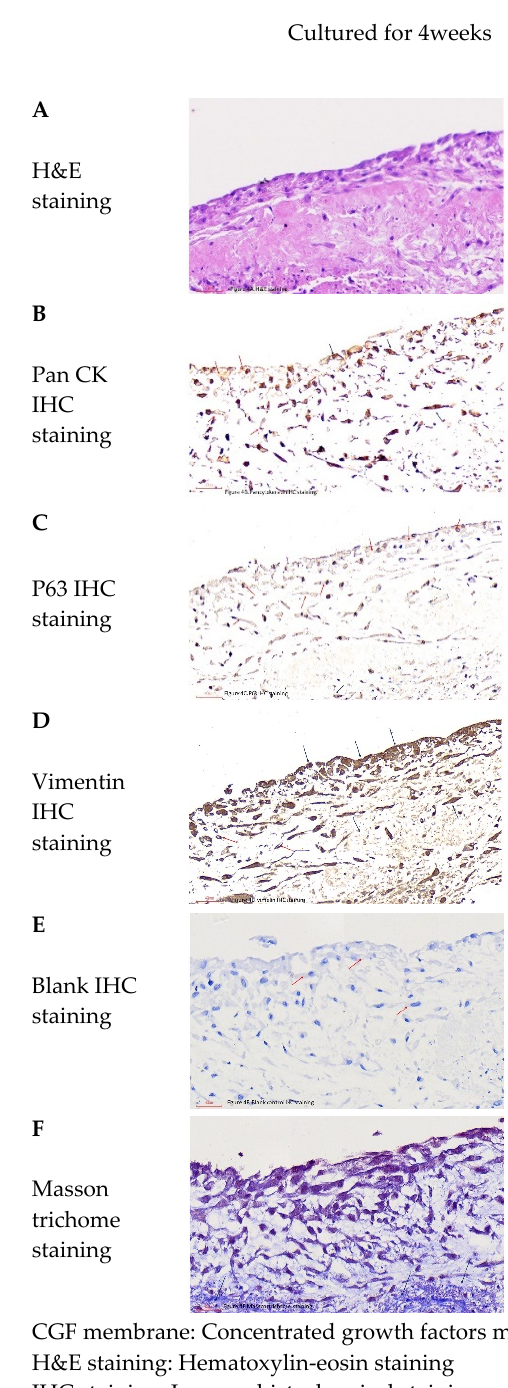
Figure 4. Human Wharton’s jelly umbilical cord mesenchymal stem cells were implanted on the platelet-poor plasma membrane and cultured for four weeks. Tissue sections were prepared from these tissue samples from the in vitro culture preparation. Hematoxylin–eosin staining, pancytokeratin and P63 cell marker immunohistochemical staining were performed. The results were compared with those from blank controls. Figure 4A: after four weeks of in vitro culture, multiple spindle shaped cells ( ) were distributed in whole-tissue sections of platelet-poor plasma membrane. Figure 4B: The tissue sections further stained for pancytokeratin. Only few cells were positive for pancytokeratin marker ( ), and most